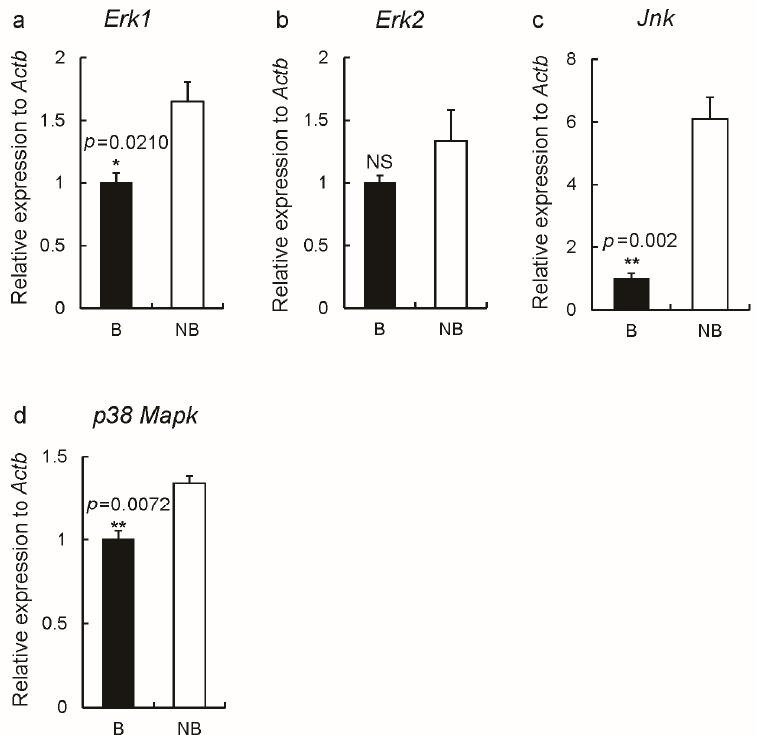
Figure 7. The gene expression levels of Erk1 ( a ), Erk2 ( b ), Jnk ( c ), and p38 Mapk ( d ) in the breeding and non-breeding periods ( n = 3 for each group). Abbreviations: B represents the breeding season; NB represents the non-breeding season. The error bars represent means ± s.e.m. * represented p < 0.05; ** represented p < 0.01; NS represents no significance.